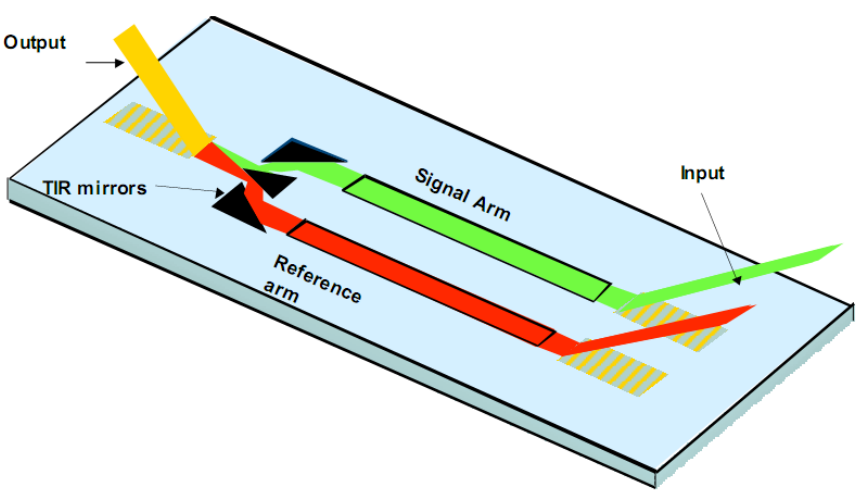
Figure 3. Physical Configuration for efficient input/output